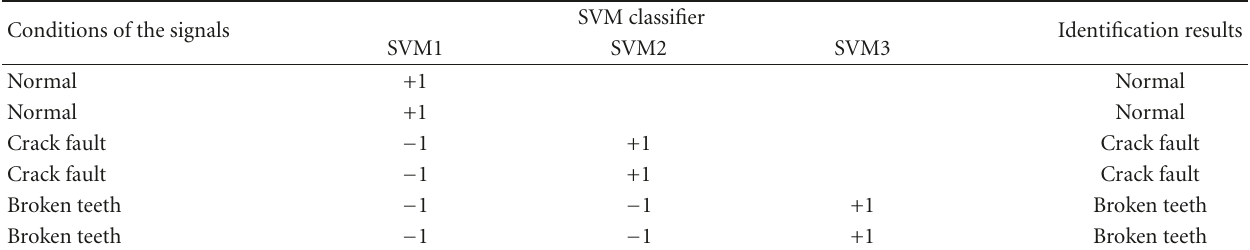
Table 2: The identification results based on IMF AR model and